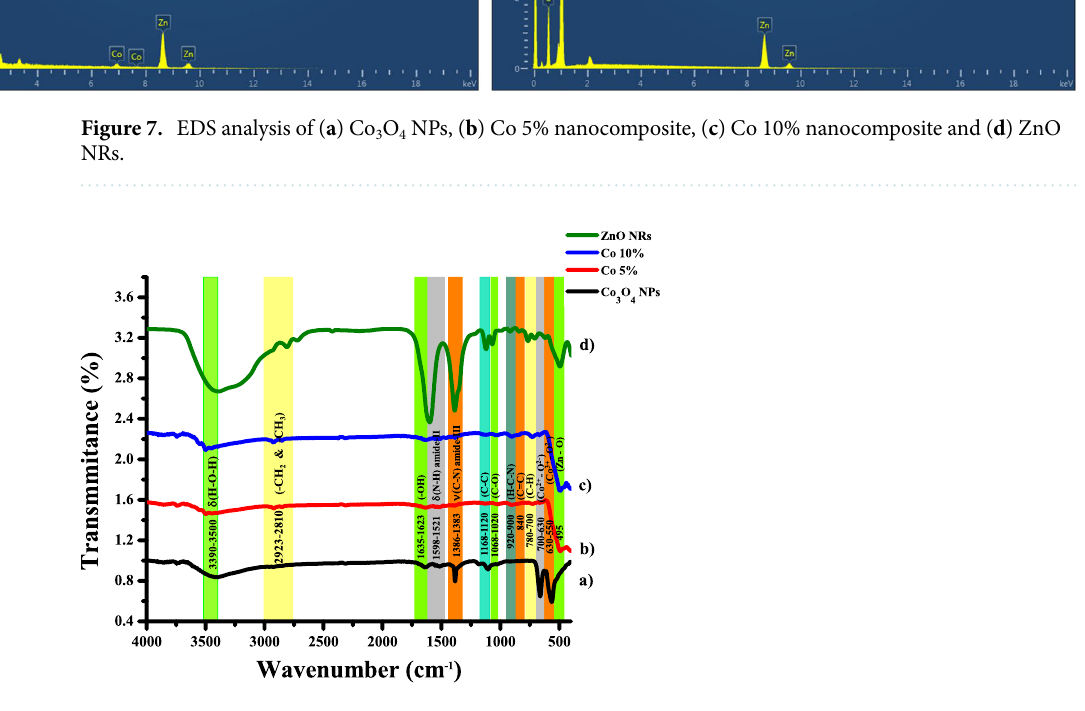
Figure 8. FTIR spectra of ( a ) Co 3 O 4 NPs, ( b ) Co 5%, ( c ) Co 10% and ( d ) ZnO